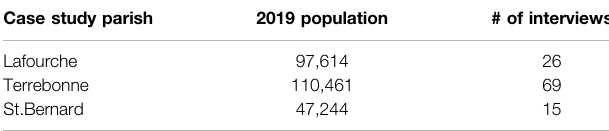
TABLE 1 | Study parish populations and the number of interviews conducted in each